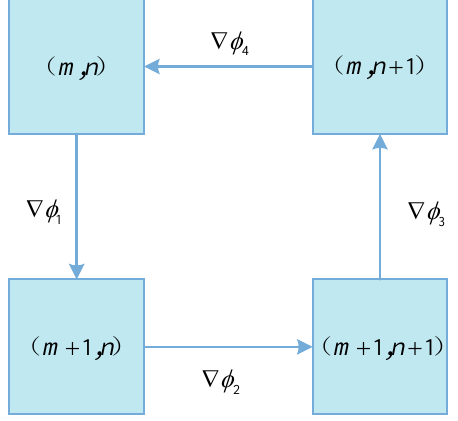
Figure 8. Schematic diagram of residue